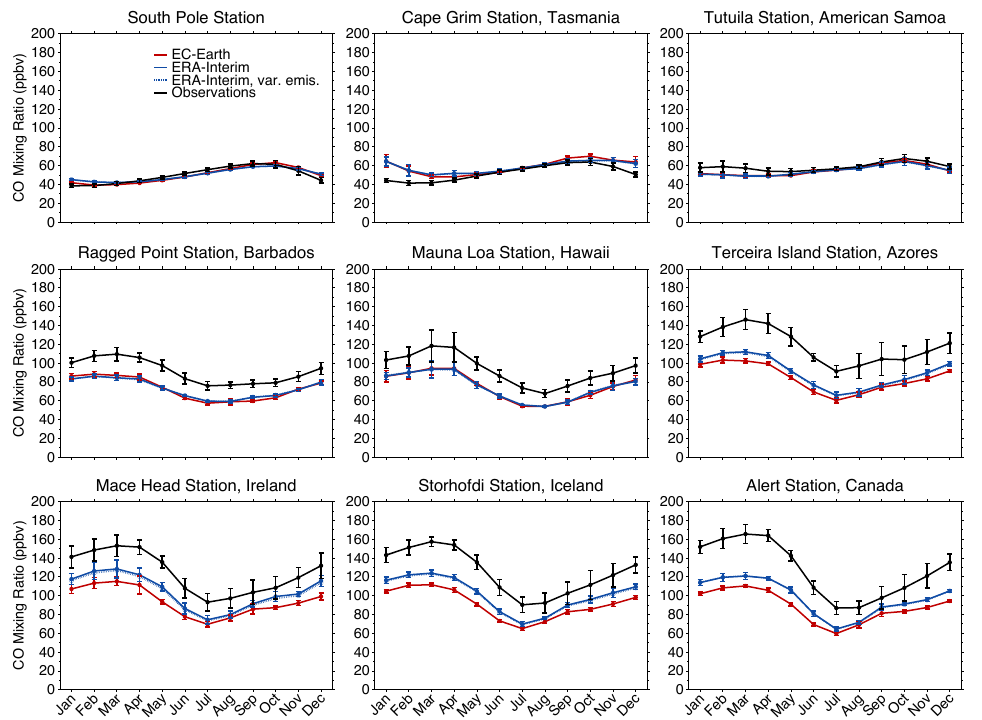
Figure 6. Comparison of monthly mean surface CO mixing ratios from the reference EC-Earth simulation (solid red lines) and the two ERA- Interim simulations (solid and dotted blue lines) against flask measurements at a number of stations selected from the NOAA GMD network. The results from the ERA-Interim simulation with interannual variations in the emissions from anthropogenic activities and biomass burning (dotted blue lines) nearly coincide with those from the ERA-Interim simulation where these emissions are fixed to their values for the year 2000 (solid blue lines). Table 5. Contributions to the budget of O 3 in the troposphere (TgO 3 year − 1 ) , together with the tropospheric O 3 burden (TgO 3 ) , and the tropospheric O 3 lifetime (days) for the reference EC-Earth simulation and the corresponding ERA-Interim simulation. The contributions from 90–30 ◦ S, 30 ◦ S–30 ◦ N, and 30–90 ◦ N are given by the numbers between parentheses. Results have been obtained from a monthly analysis with a fixed tropopause level, set to the uppermost model layer for which the monthly mean O 3 mixing ratio is below 150ppbv. Standard deviations are based on the simulated interannual